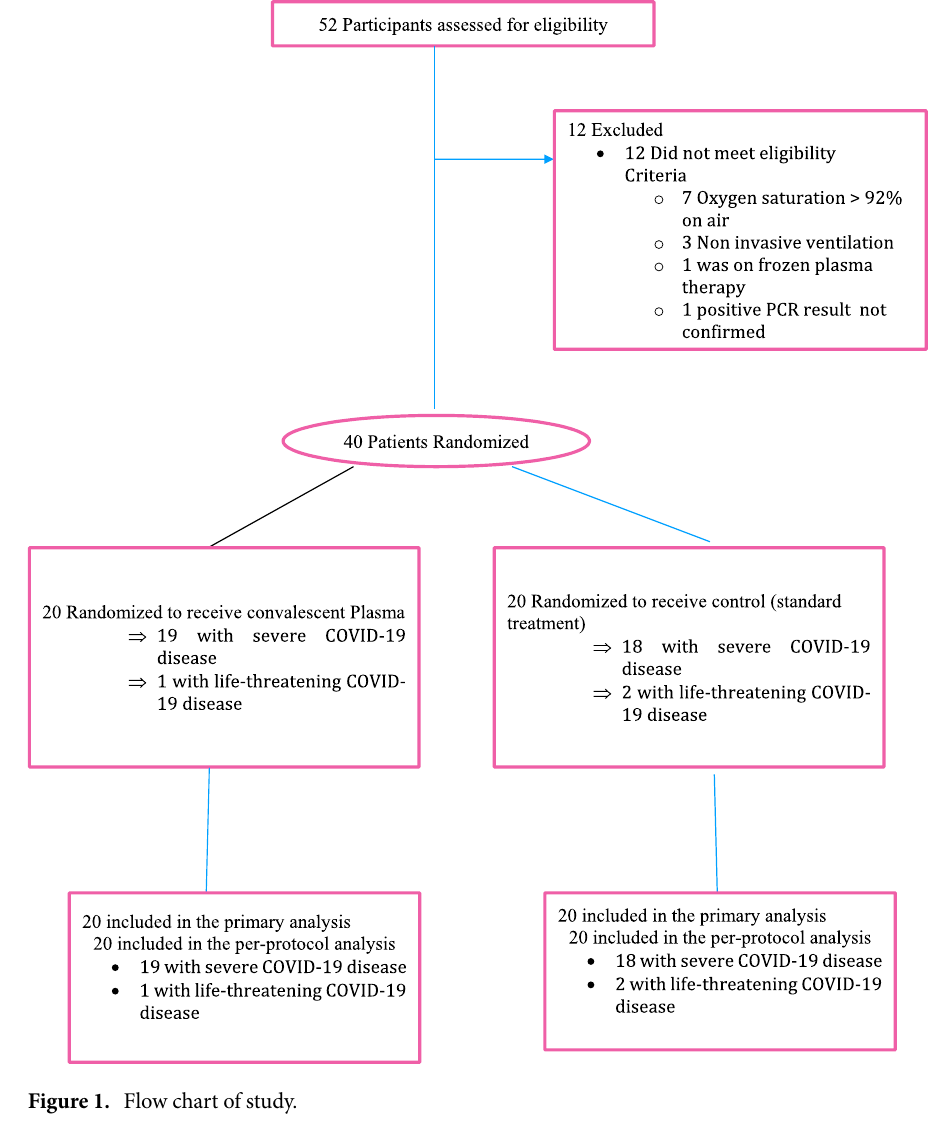
Figure 1. Flow chart of